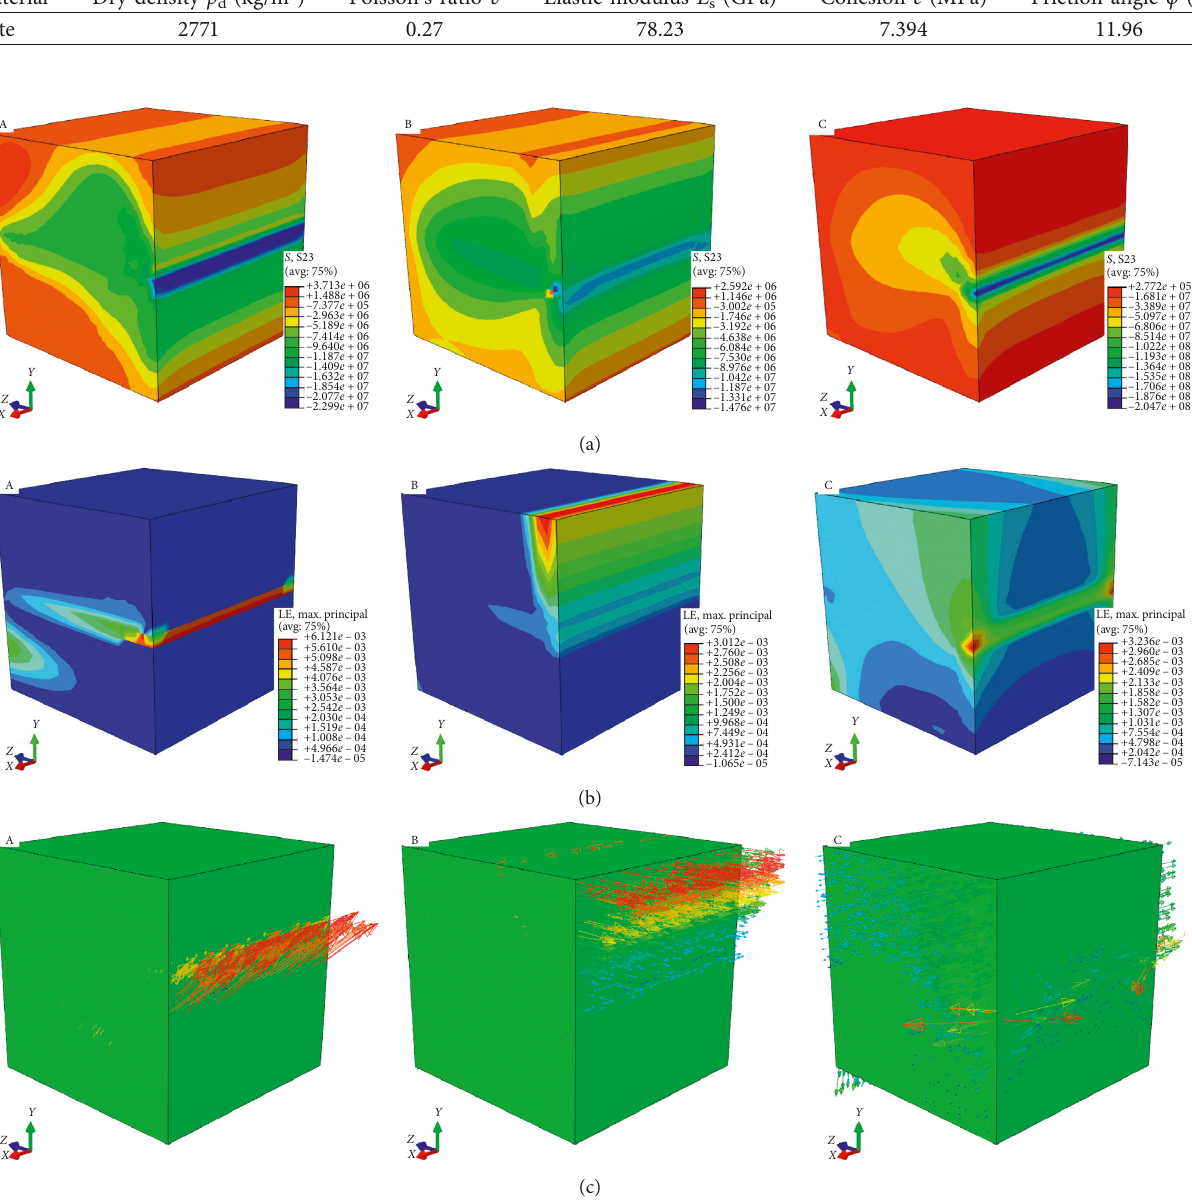
Figure 13: Results of numerical simulation. (a) Shear stress. (b) Logarithmic strain. (c) Logarithmic strain